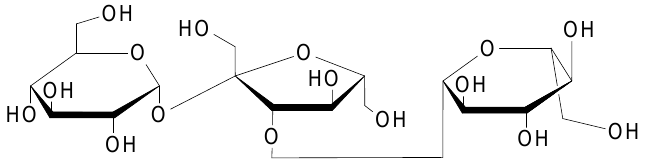
Figure 4. Melecitose structure.